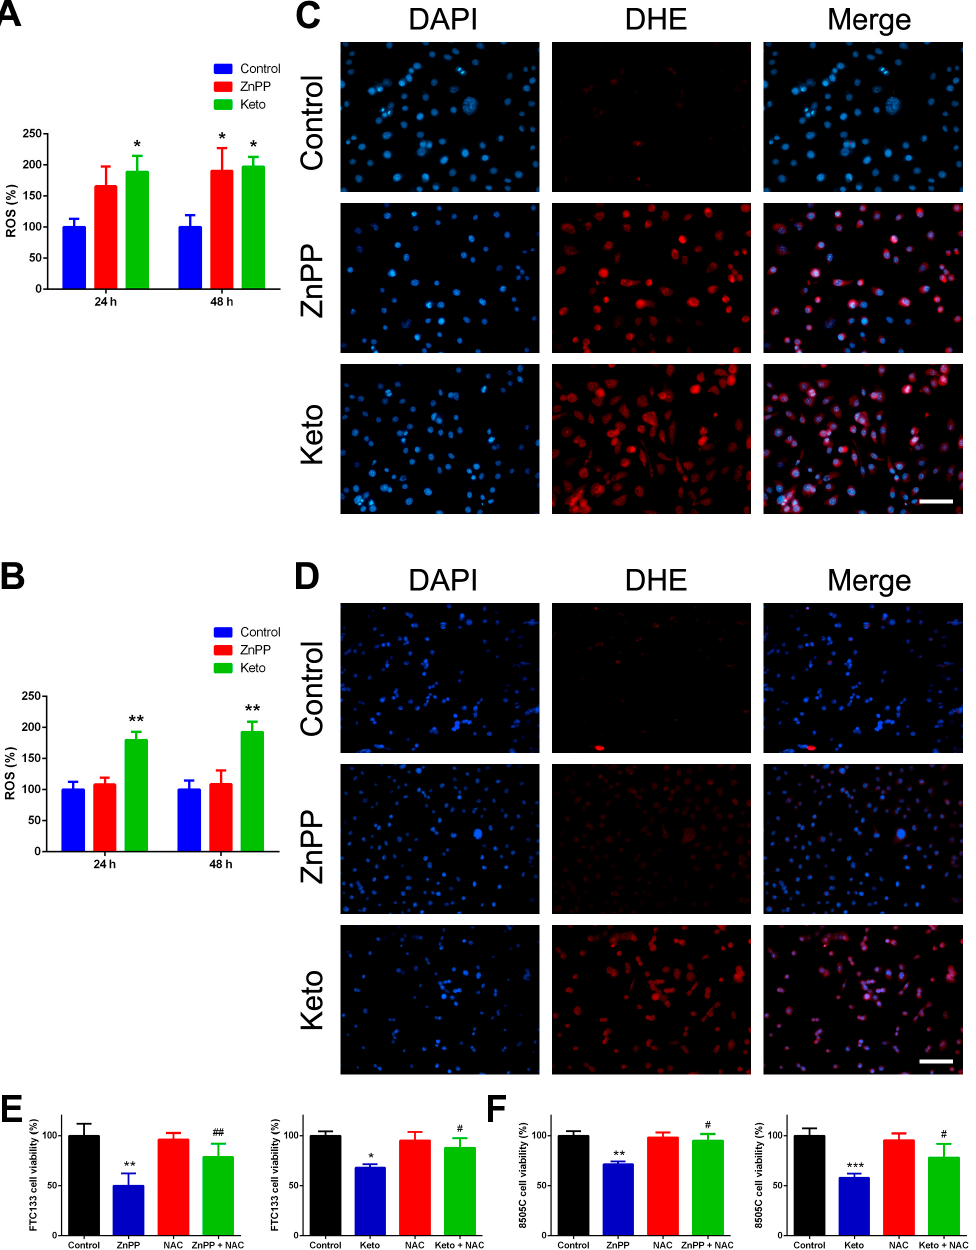
Figure 3. Reactive oxygen species (ROS) induction by heme oxygenase-1 inhibitors in thyroid cancer cells and effects of ROS scavenger. Following treatment with zinc protoporphyrin-IX (ZnPP), ketoconazole (Keto), or vehicle control, intracellular ROS was quantified by the Cellular Reactive Oxygen Species Detection Assay Kit ( A , B ) or by dihydroethidium (DHE) staining ( C , D ). * p < 0.05 versus control, ** p < 0.01. Scale bar, 100 μ m. Cell viability was determined by the CyQUANT Cell Proliferation Assay following treatment with ZnPP, Keto, N -acetyl- L -cysteine (NAC), or cotreatment with heme oxygenase-1 inhibitors and NAC for 48 h. * p < 0.05 versus control, ** p < 0.01, *** p < 0.001. # p < 0.05 versus ZnPP or Keto only, ## p < 0.01.